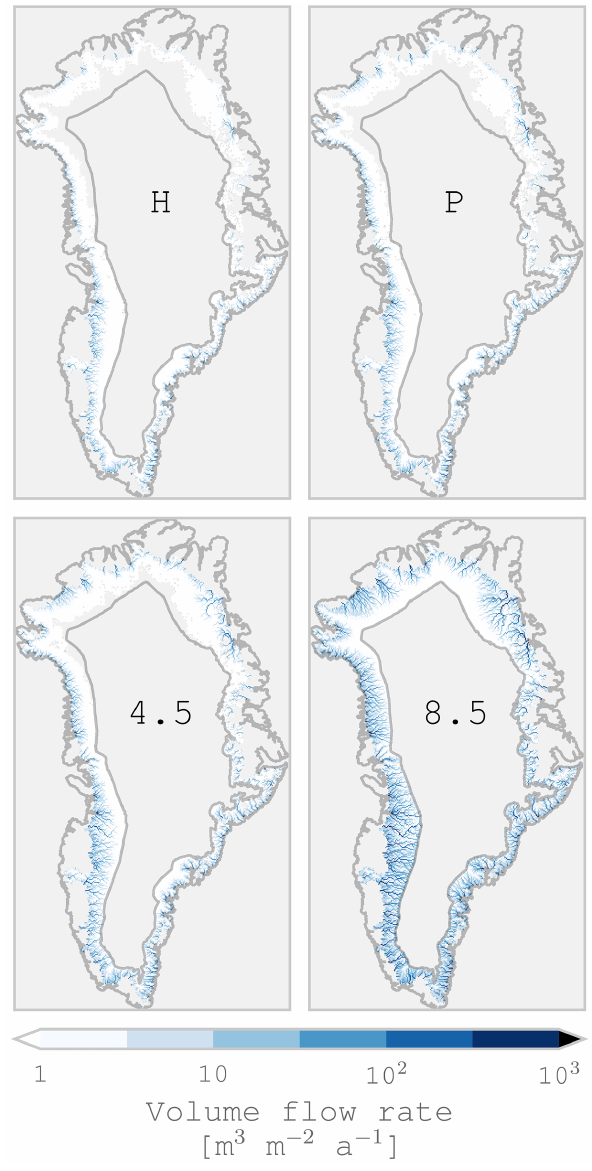
Figure 1. Accumulation of subglacial water flowing through each grid cell. Results are presented on a 5km × 5km grid. Labels rep- resent historical (H) mean from 1960 to 1999, present (P) mean from 2010 to 2019, 4.5 spans years 2090–2099 under IPCC AR5 RCP4.5, and 8.5 is the same as 4.5 but under scenario RCP8.5. Gray contours mark 0 and 2000m